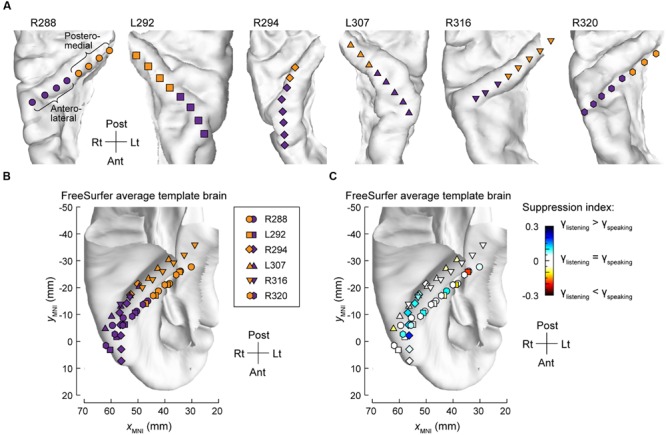
Anatomical parcellation of HG and summary of SI analysis. (A) MRI superior temporal plane top-down views showing the locations of recording contacts chronically implanted in HG in all subjects. Recording sites assigned to posteromedial and anterolateral ROIs as described in Section “Materials and Methods” are shown in orange and purple, respectively. (B) Locations of all posteromedial and anterolateral HG sites (orange and purple symbols, respectively) plotted in MNI coordinate space and projected onto the FreeSurfer average template brain. Different symbol shapes correspond to different subjects. (C) Color-coded SI values (threshold ± 0.05), plotted in MNI coordinate space and projected onto FreeSurfer average template brain. Different symbol shapes correspond to different subjects (as shown in the legend of panel B).